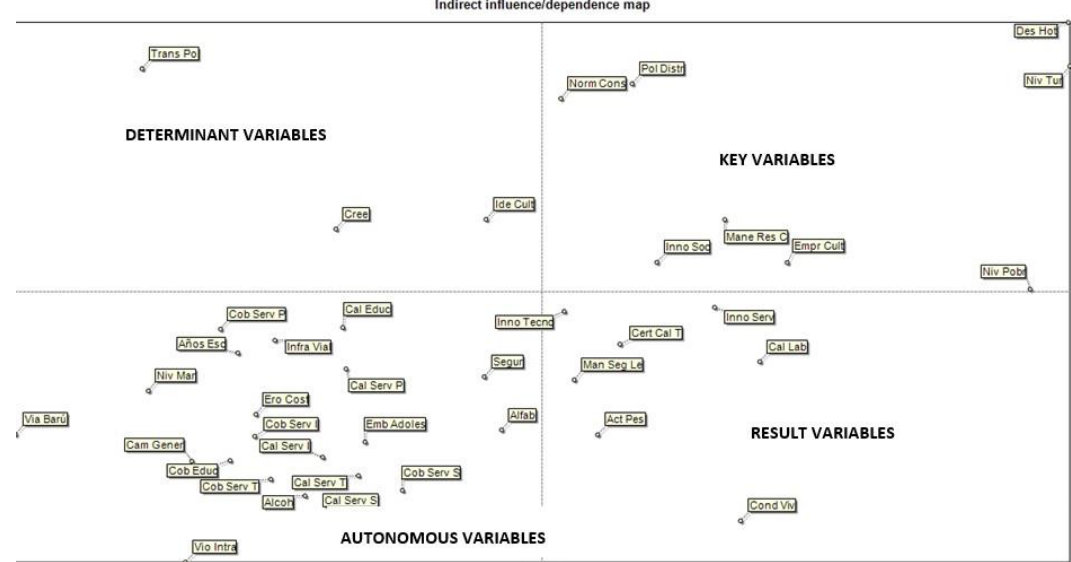
Figure 1. Matrix of indirect influence –